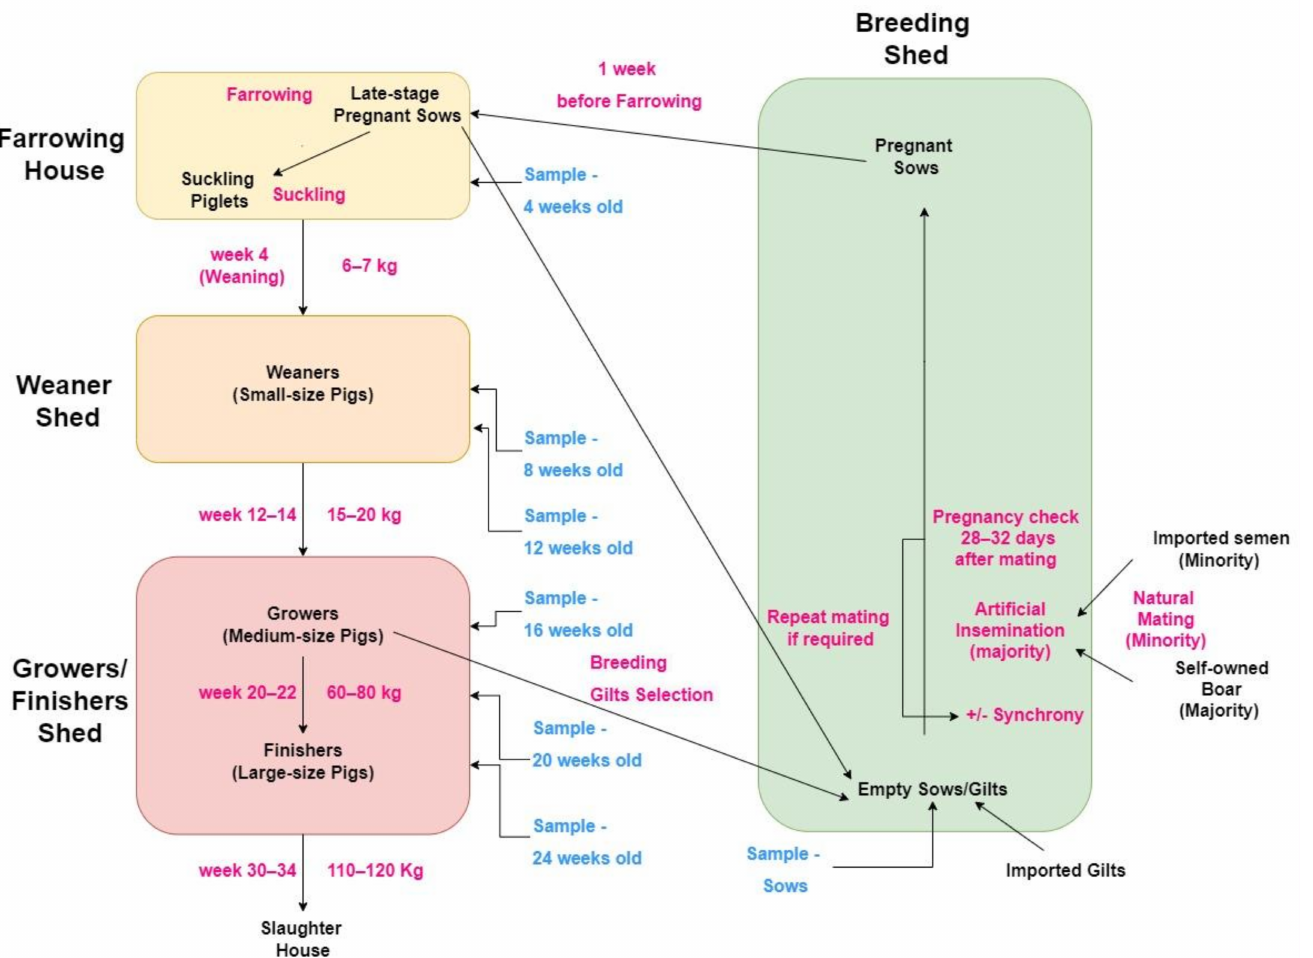
Figure 1. Pig production system in the Hong Kong Special Administration Region showing different production stages and ages and the different age groups that were selected for sampling (‘sample’) in the present